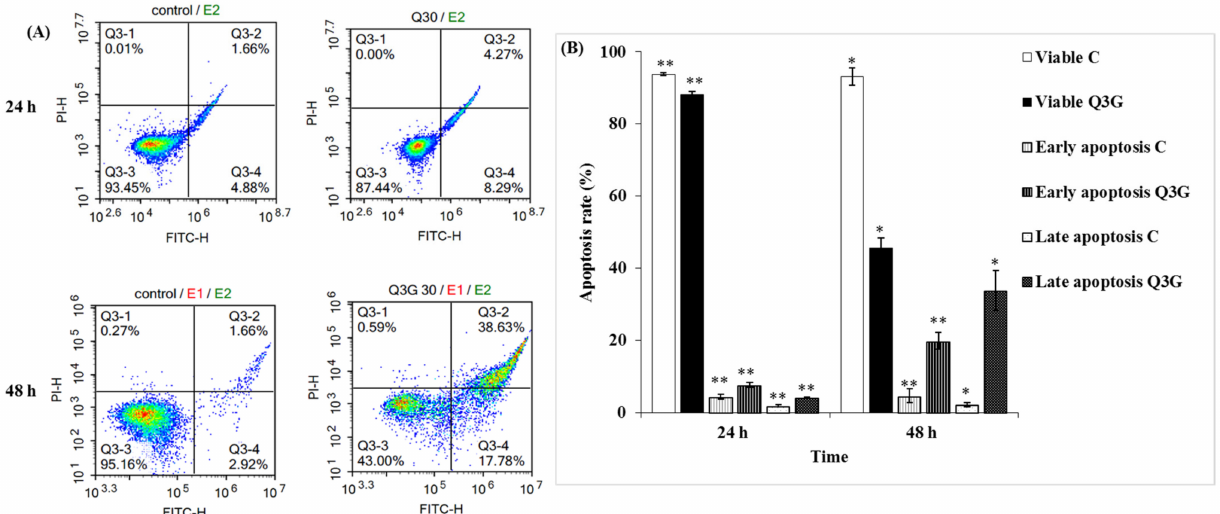
Figure 4. Q3G induces time-dependent apoptosis in Hela cells. ( A ) PI and FITC-Annexin V co-staining identified cell death of Hela cells with or without 30 µ g Q3G treatment analyzed by flow cytometry. ( B ) Graph shows the percentages of apoptotic cells. Experiments were performed in triplicate, and the results were expressed as mean ± SD. C: Control, DMSO: dimethyl sulfoxide, PI: propidium iodide, FITC: fluorescein isothiocyanate, Q3G: Quercetin 3- β -D-glucoside. Significantly different from control group, * p < 0.05, ** p <